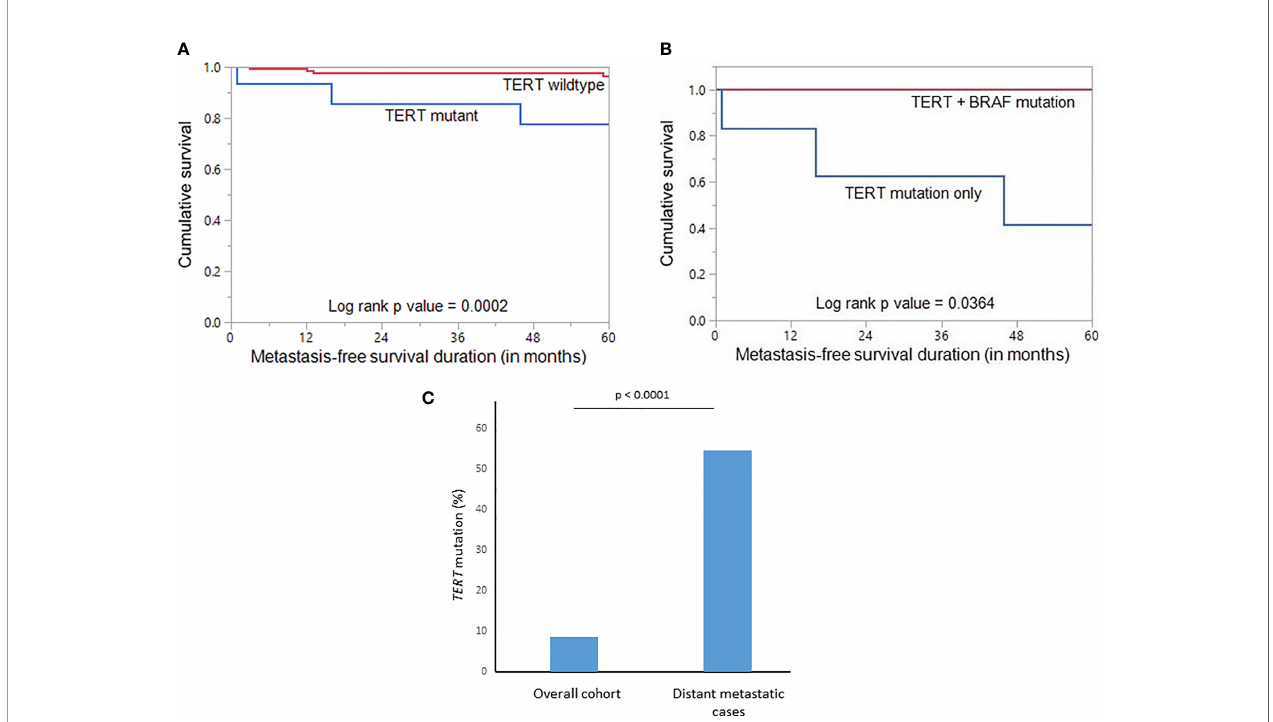
FIGURE 2 | (A) Kaplan-Meier survival curve showing shorter metastasis-free survival in TERT mutant cases compared to TERT wildtype (p = 0.0002). (B) Kaplan- Meier survival curve showing shorter metastasis-free survival in TERT mutant only cases compared to TERT+BRAF mutant cases (p = 0.0364). (C) Signi fi cantly higher frequency of TERT mutation was noted in the distant metastatic cases compared to the overall cohort of papillary thyroid microcarcinomas (p < 0.0001).